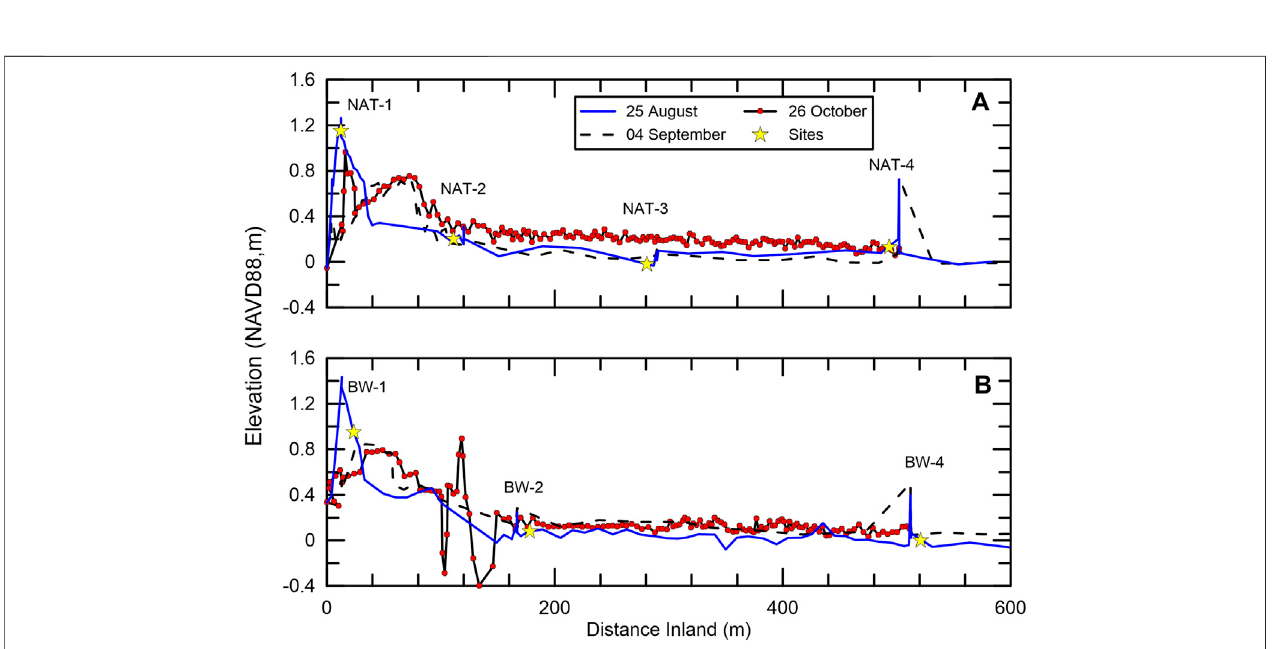
FIGURE8| RTK-GPSelevationtransectsfromtheshorelineinlandforthenaturalshoreline (A) andthe (B) breakwaterprotectedshorelineshowingthelocationsof study sites on 25 August 2020, 4 September 2020, and 26 October 2020.